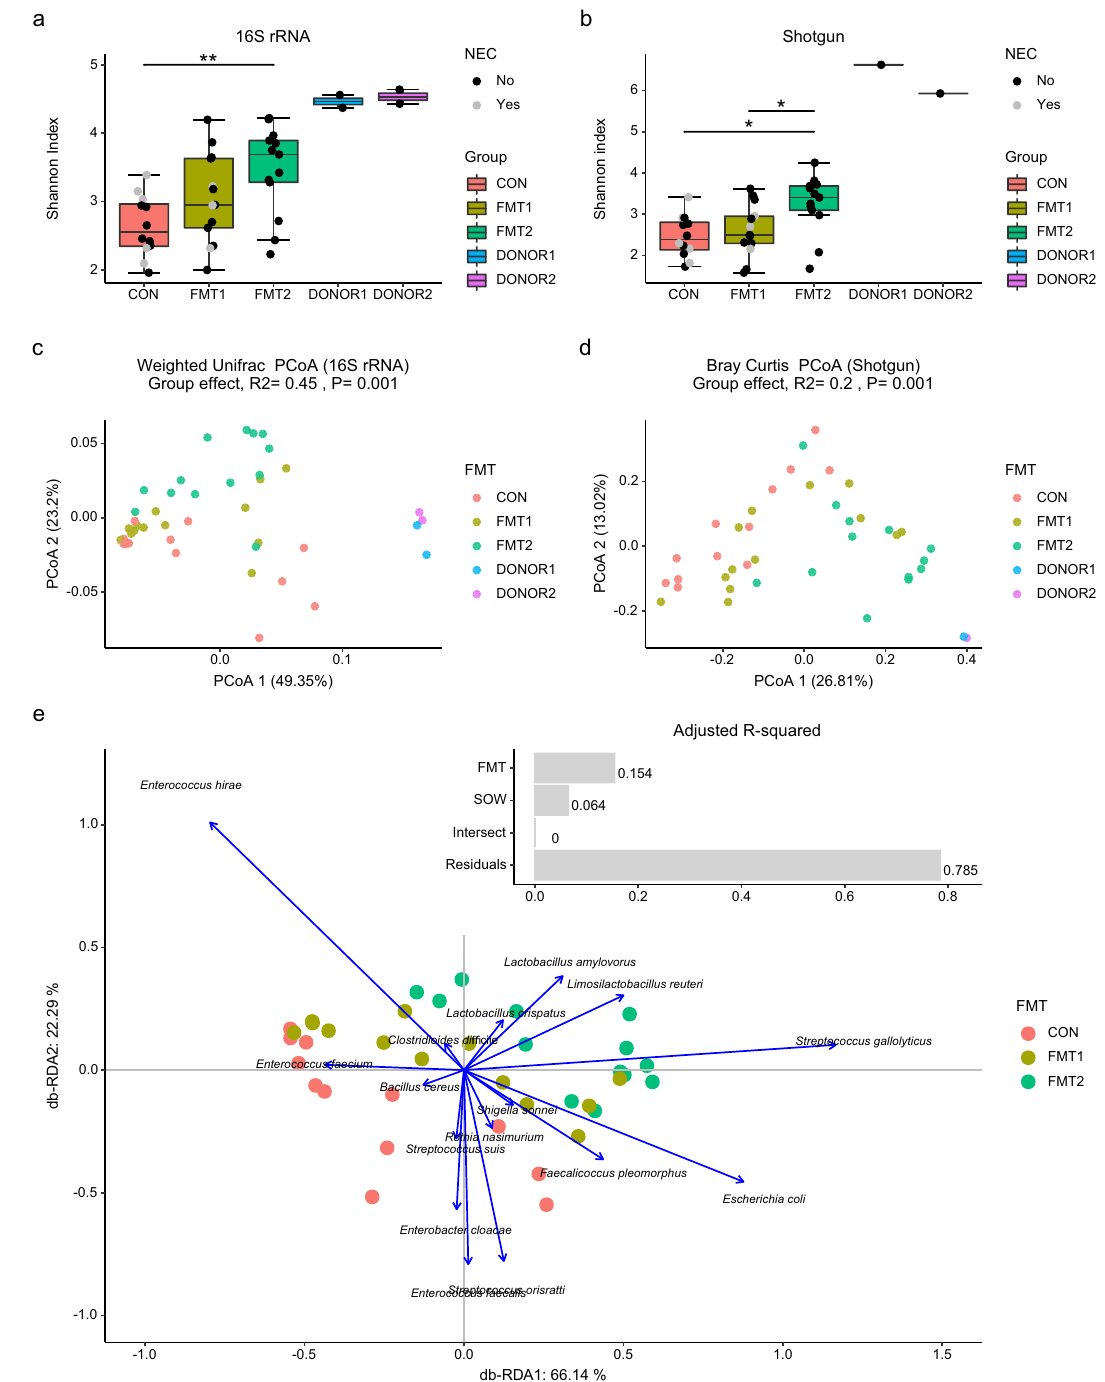
Fig. 3 Fecal microbiota transplantation shifted the recipient gut microbiota in a donor-dependent manner. Shannon index calculated from 16S rRNA gene amplicon sequencing ( a ) and Shotgun metagenomics ( b ); Unsupervised PCoA plots based on weighted UniFrac ( c ) and Bray Curtis dissimilarity metrics ( d ), and the db-RDA biplot showing the variance explained by FMT and SOW and the scaled loadings of core species (mean relative abundance > 1%) ( e ). The labels of * and ** represent adjusted p < 0.05 and 0.01 (Wilcoxon rank-sum test for Shannon index and PERMANOVA for beta diversity). Respectively n = 13, 13, 12 for FMT1, FMT2 and CON. In boxplots, the inner fences are depicted as error bars. FMT1 rectal FMT with Donor 1, FMT2 rectal FMT with Donor 2, CON rectal FMT with sterile saline as control, NEC necrotizing enterocolitis, 16S rRNA 16S ribosome RNA gene amplicon sequencing, Shotgun Shotgun (Fig. 7c). The Donor 2-speci fi c MAGs possessed more KEGG speci fi c phylogenetic separation of the MAGs was found modules of heparan sulfate degradation (M00078, adjusted p < (Supplementary Fig. 7). 0.005, Fisher ’ s exact test with Benjamin-Hochberg correction), The functional similarity of donor-speci fi c MAGs was com- keratan sulfate degradation (M00079, adjusted p < 0.01, Fisher ’ s pared based on the presence of KEGG modules in the genomes